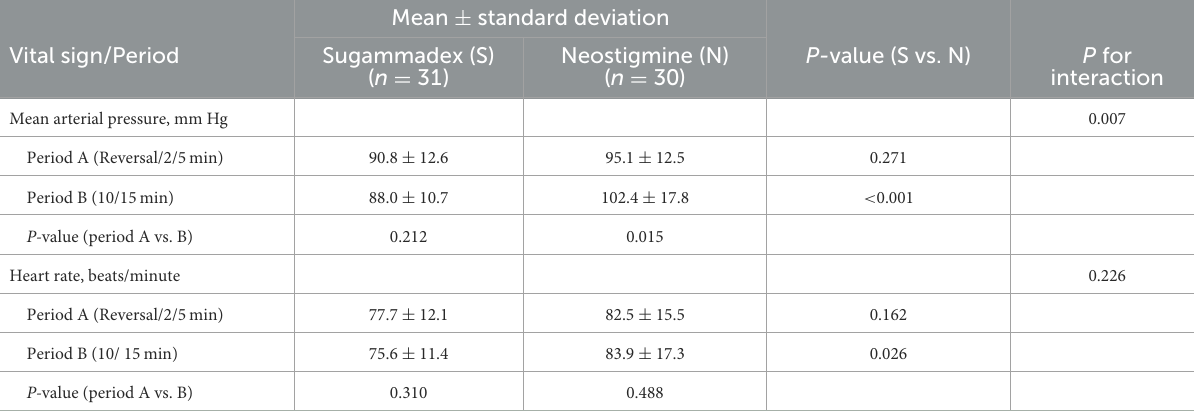
TABLE 2 Comparison of vital signs between the sugammadex and neostigmine groups ∗ .